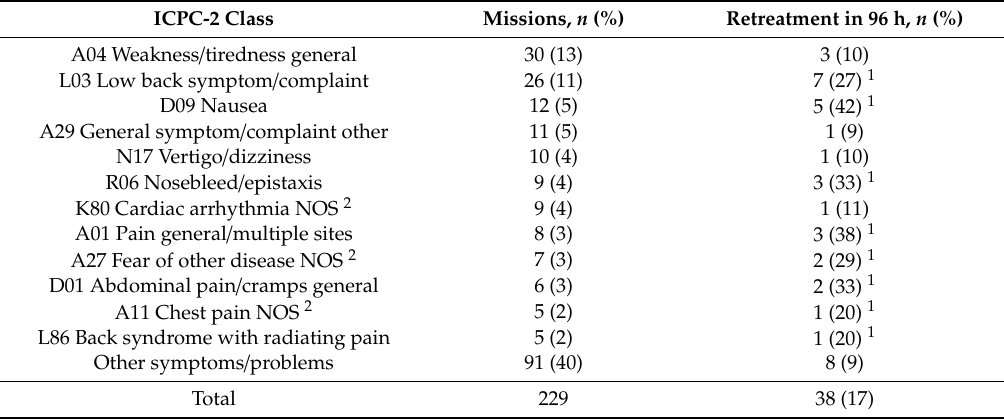
Table 1. The CP unit visits by the ICPC-2 class and patient group retreatment rates in the ED within 96